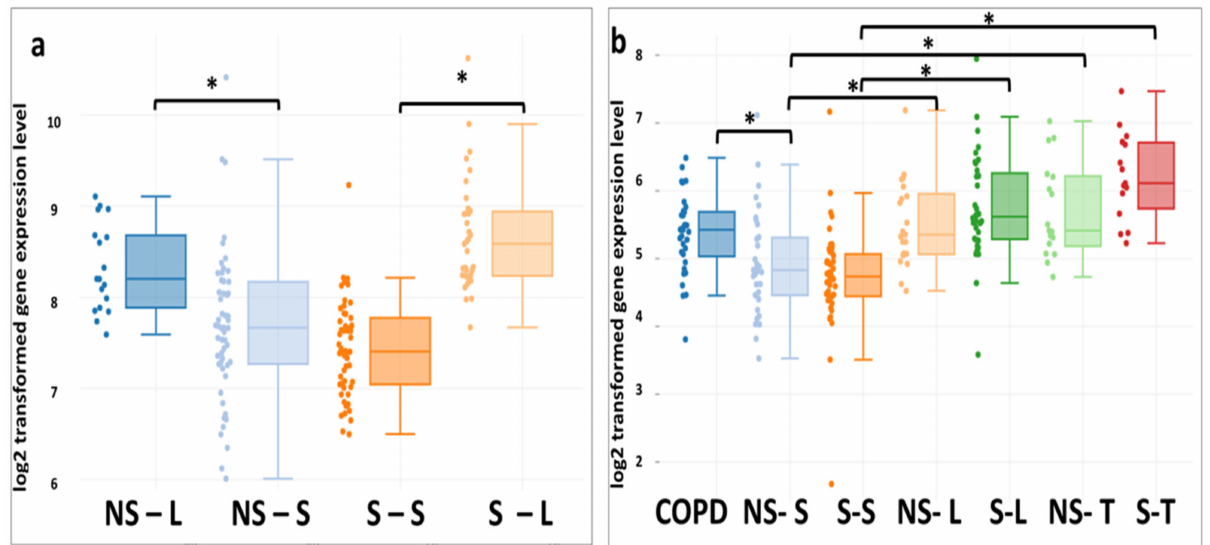
Figure 4. Patterns of ABCA1 expression in the epithelium of the upper and lower respiratory tract ( a —GSE18385; b — GSE11906) associated with smoking status: non-smokers–large airways (NS–L), non-smokers–small airways (NS–S), smokers–large airways (S–L), smokers–small airways (S–S), non-smokers–trachea (NS–T), non-smokers–trachea (NS–T), diagnosis of COPD–small airways (COPD). All datasets were generated from the Affymetrix Human Genome U133 Plus 2 microarray platform (using the Mas 5.0 Normalization method). The data distribution is visualized in the form of box diagrams. Statistically significant differences ( p values and p values adjusted using the algorithm of Benjamini & Hochberg) are shown with asterisks: * p < 0.01, FDR ≤